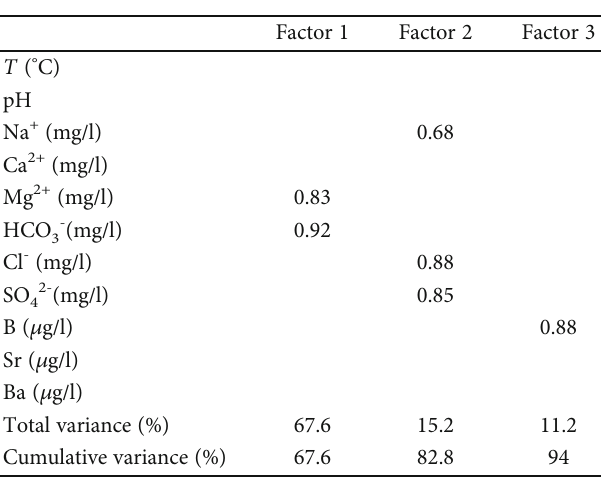
Table 3: Matrix of factor weights after varimax rotation using the STATGRAPHICS 18 package.